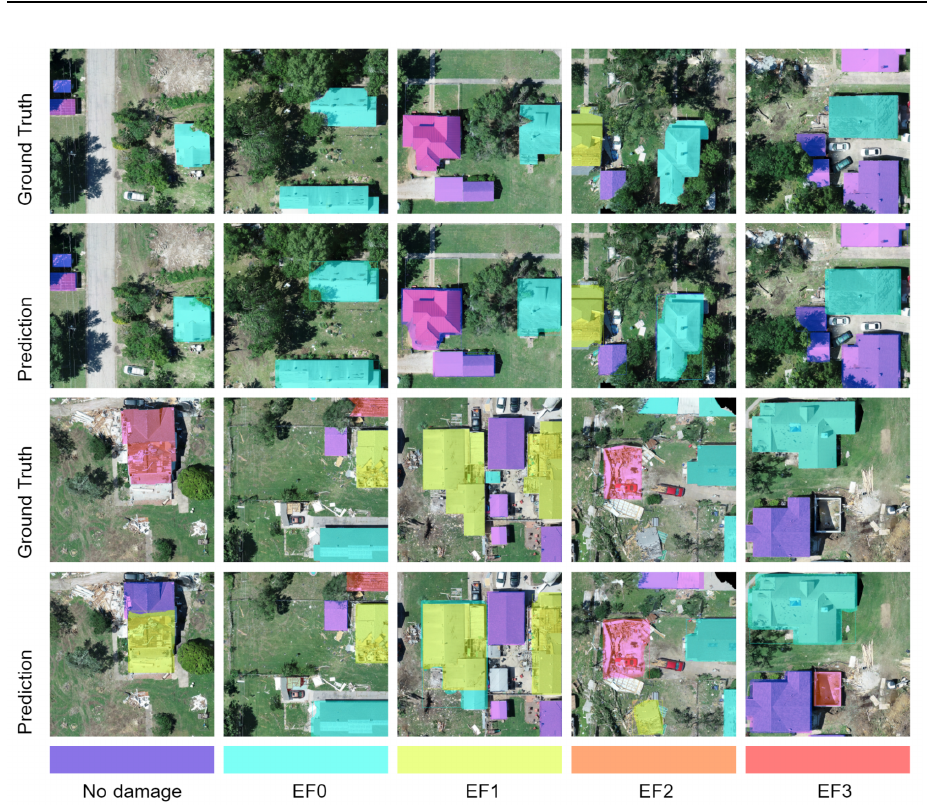
Figure 5. Examples of neural network inference and ground truth for multi-class object detection from validation and test datasets. Original image tiles are overlaid with masks from prediction or ground